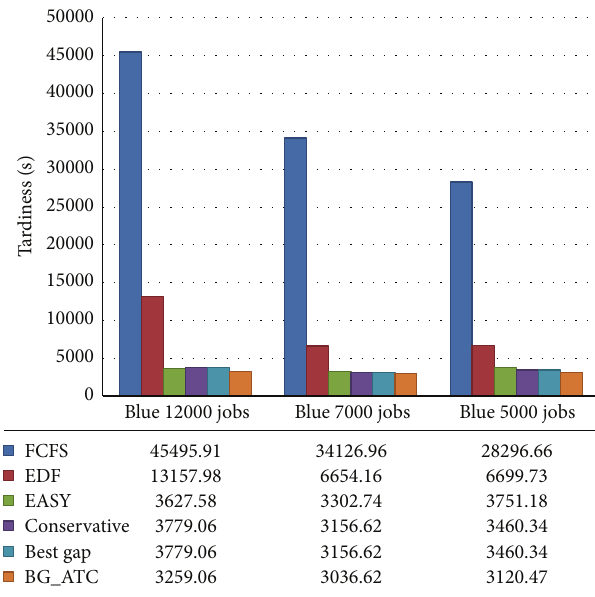
Figure 3: Tardiness analysis on metacentrum workload.